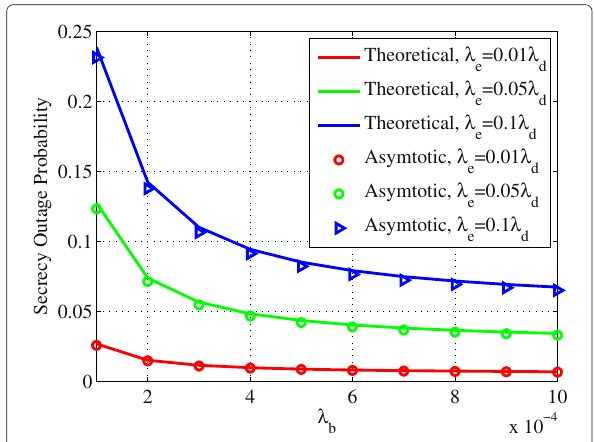
Fig. 3 The secrecy outage probability of the typical cellular link versus the density of the base station λ b under different densities of the eavesdropper λ e inscenarioIIwhere λ d = 0.001 / m 2 , φ =